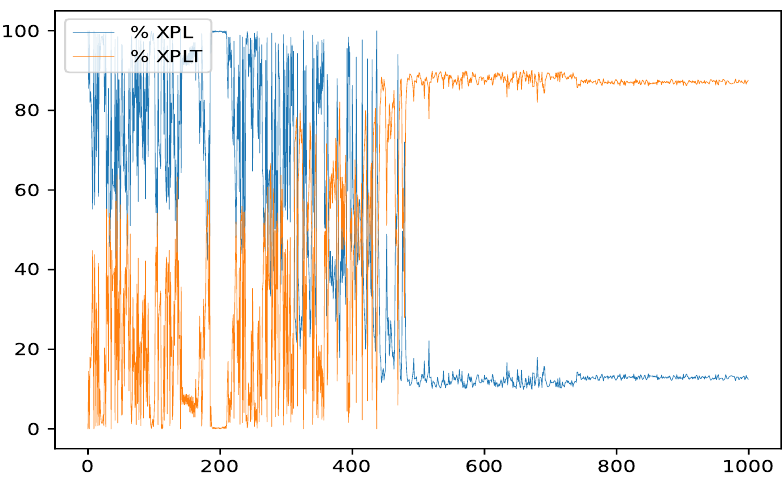
Figure 20. HHO-MIR-d5 Dimensional Hussain.